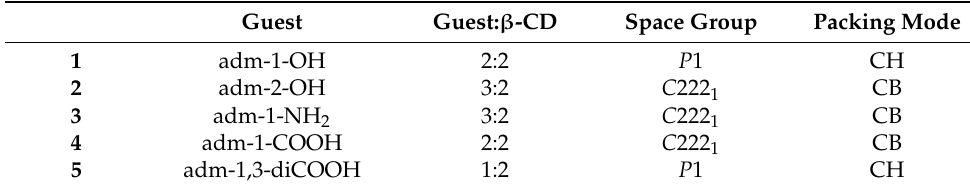
Figure 2. ( a ) The ITC isotherm for the titration of β -CD (1.0 mM) into a solution of adm-1-COOH (0.1 mM), in 5% DMSO-water solution at 25 ◦ C. ( b ) The ITC isotherm for the titration of β -CD (1.0 mM) into a solution of adm-1,3-diCOOH (0.1 mM), in 5% DMSO-water solution at 25 ◦ C. Table 2. A list of the packing modes of 1 –